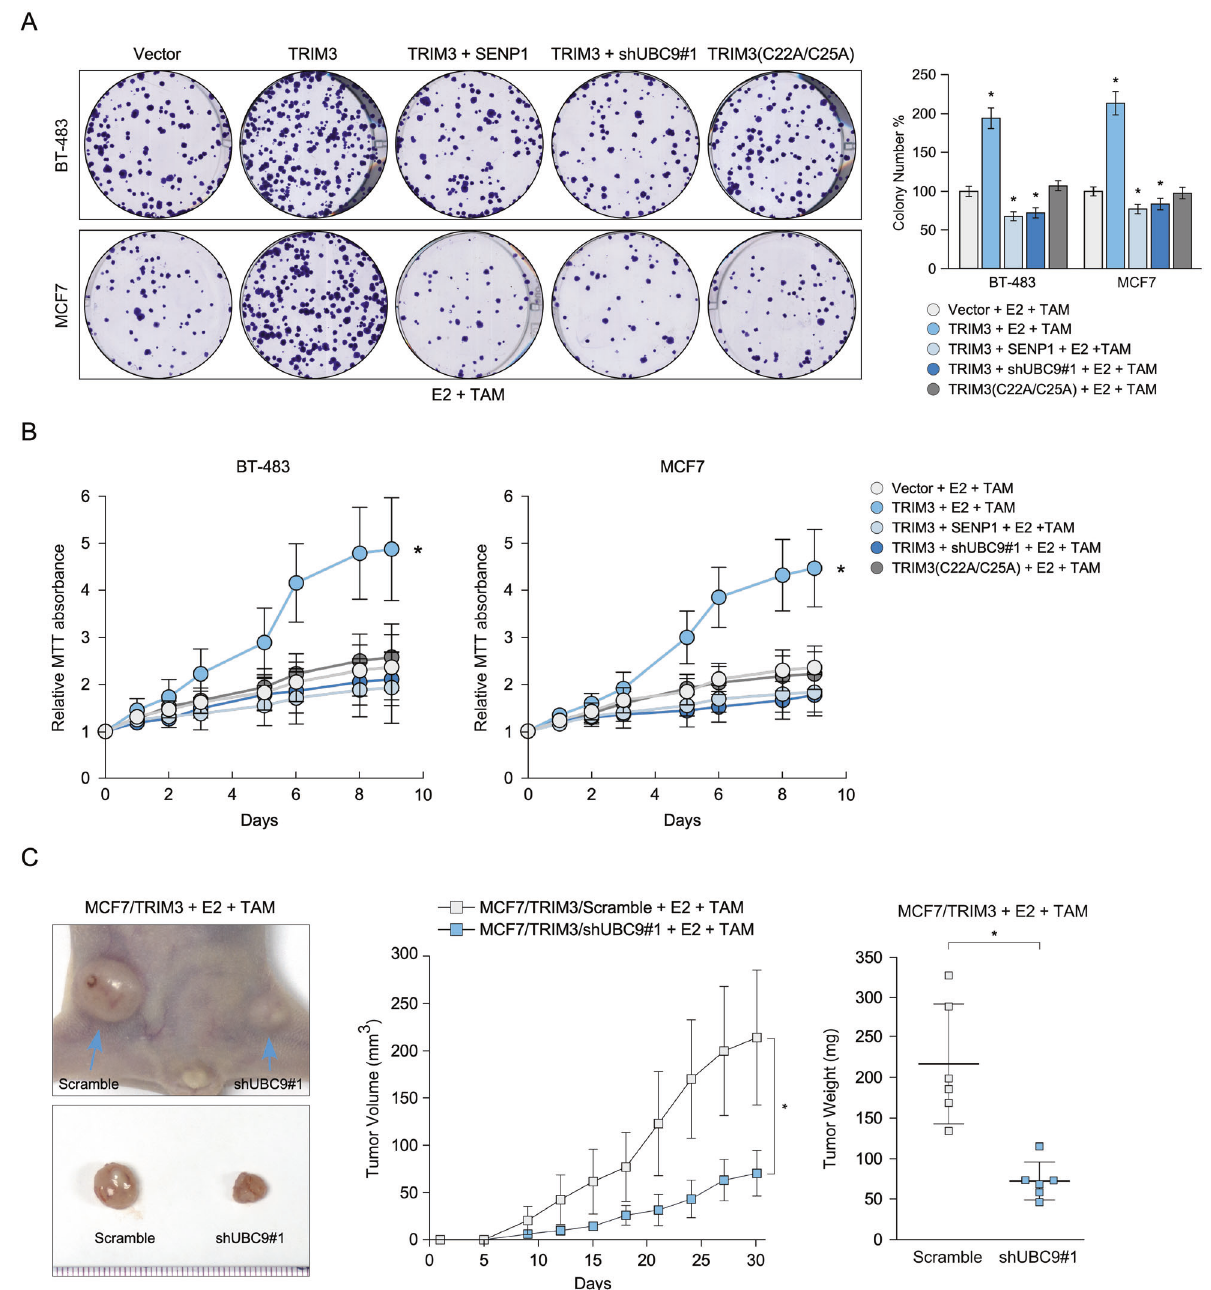
Fig. 5 Silencing UBC9 reverses the tamoxifen resistance effect of TRIM3. Representative images of colony formation ( A ) and MTT assays ( B ) of the indicated cells treated with E2 (10 nM) and TAM (1 μ M). Histograms showing colonies formed by the indicated cells. Data are presented as the mean ± SD. * P < 0.05. C Representative images of the tumors in the xenografts (left panel), tumor growth curves (middle panel) and tumor weight (right panel) of the indicated xenograft tumors ( n = 6/group). Data are presented as the mean ± SD. * P <